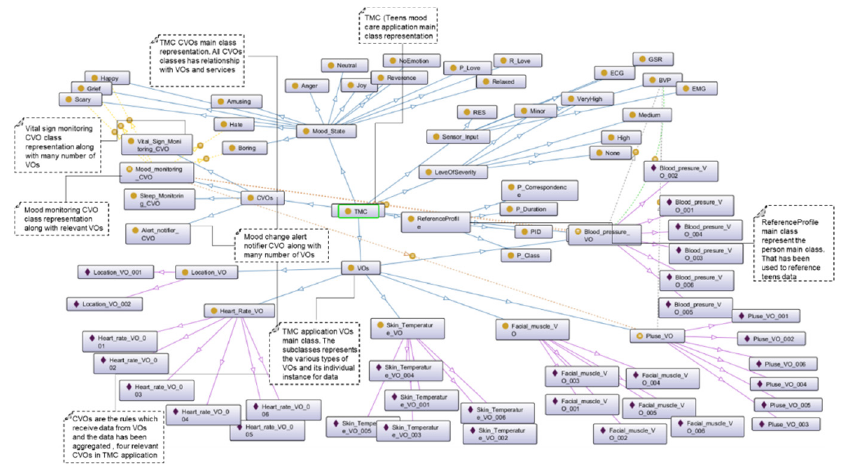
Figure 20. TMC application VOs and CVOs ontology model.